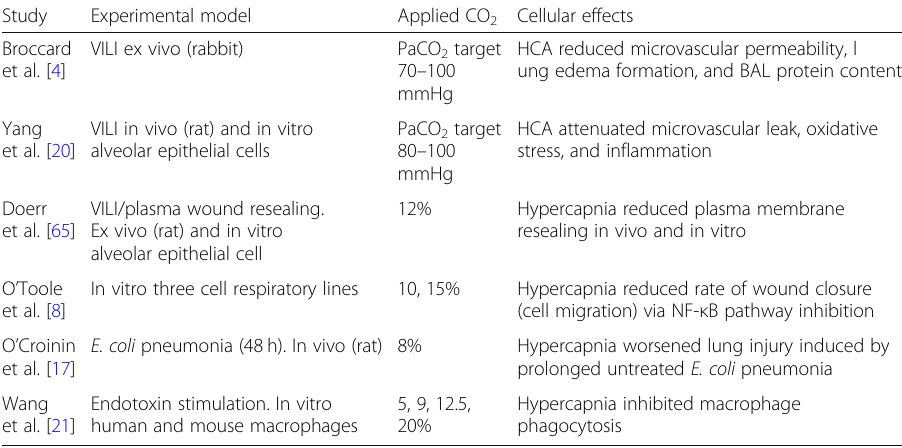
Table 1 Alveolar cellular effects of hypercapnia: summary of in vivo and ex vivo experiments on the effects of